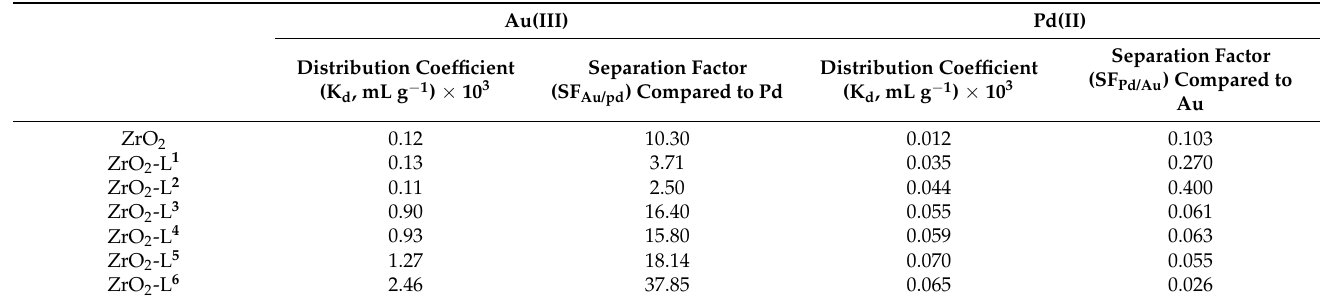
Table 3. The distribution coefficient and separation factor values of Au(III) and Pd(II). Au(III) Pd(II) Distribution Coefficient (K d , mL g − 1 ) × 10 3